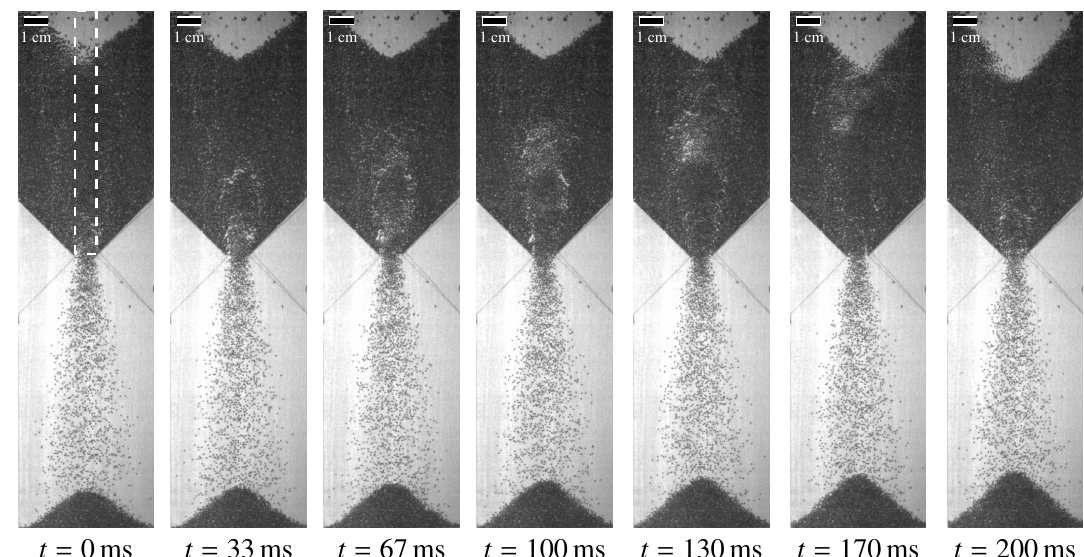
Figure 3. Image sequence of a silo discharge in the case of the maximum magnetic field intensity ( Ψ = 62). The images were taken at regular time steps and we can see a defect wave, where the beads are free falling inside the structure, going upward. The full sequence of 200ms corresponds to a propagation cycle where the defect emerges at the funnel neck and go up to the free surface of the structure. The white dashed window shown in the first panel represents the window used for the spatio-temporal maps displayed in figure